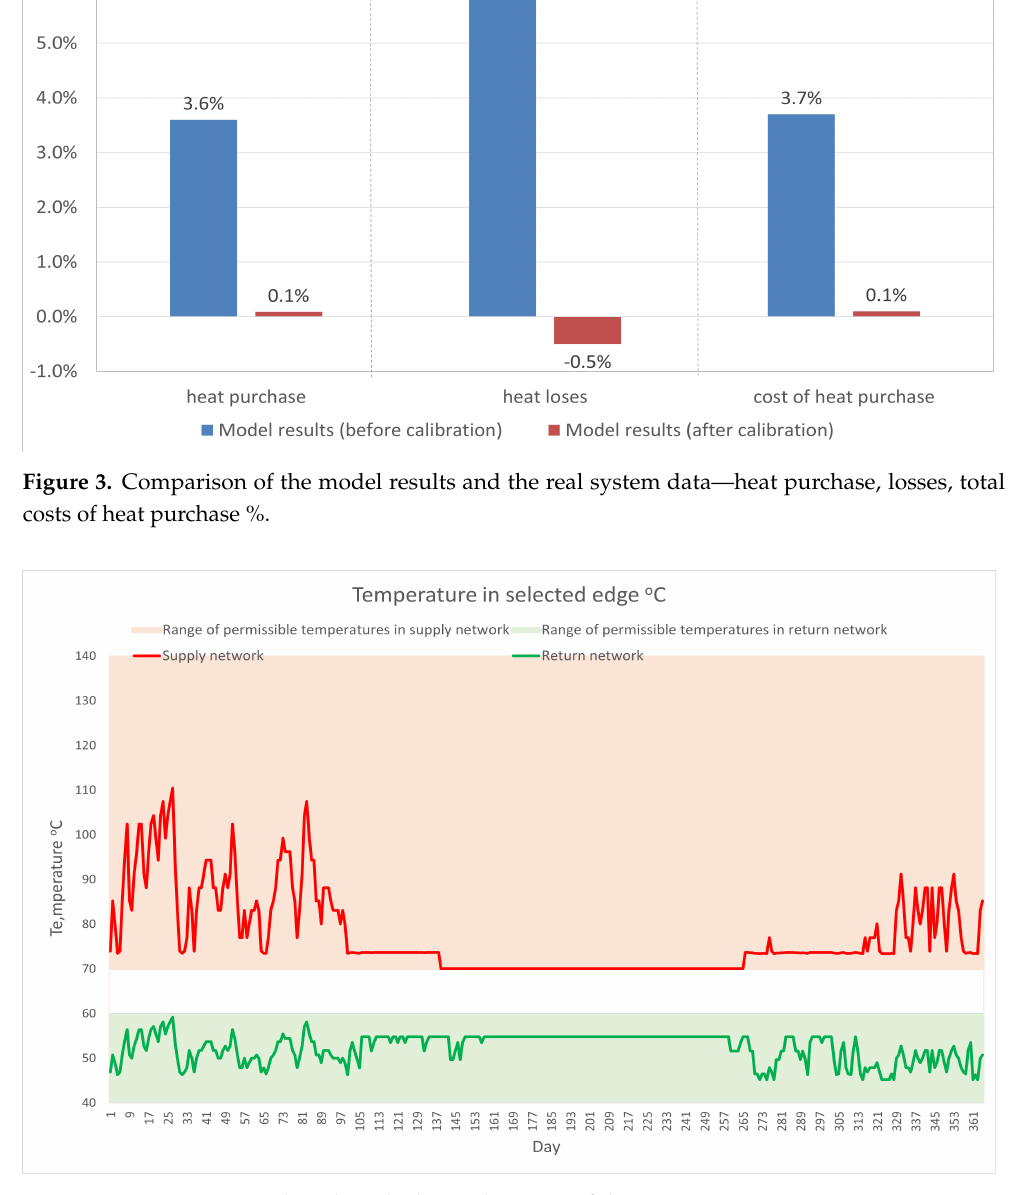
Figure 4. Temperature in the selected edge in the range of the